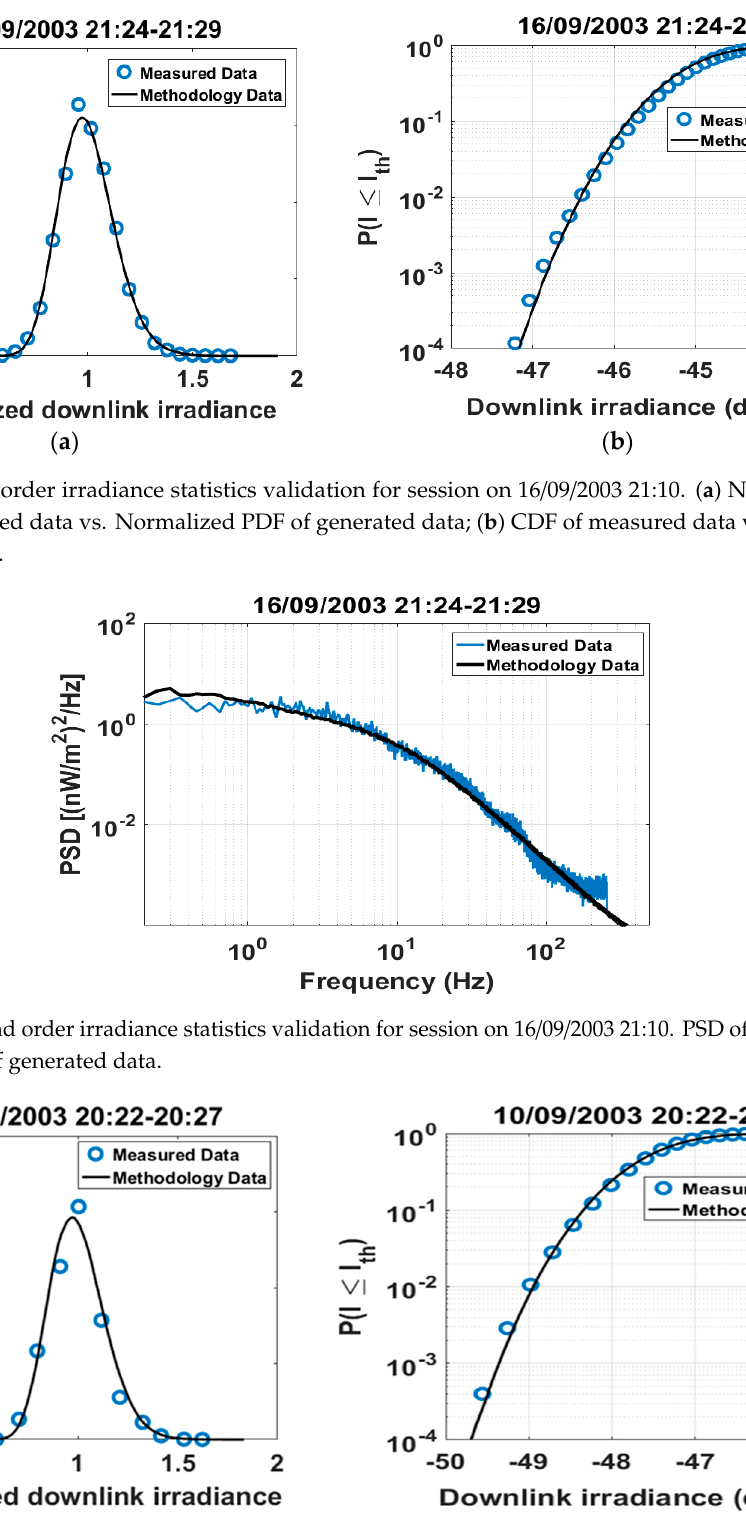
Figure 9. Second order irradiance statistics validation for session on 10/09/2003 20:10. PSD of measured data vs. PSD of generated data. It was observed that the long-term irradiance statistics are re-produced by the proposed synthesizer and fully represent the experimental ones. Concerning the first order statistics results, the scintillation indexes computed from the time- series generated are very similar to the measured ones as well as the corresponding normalized PDFs and CDFs which almost coincide. It is clear that the various wind speeds on the vertical (to the slant path) path cause different turbulence conditions and the larger the wind speed, the greater the SI value. Regarding the second order statistics results, the methodology-obtained PSDs show good agreement with the ones computed from the optical experimental data. Moreover, it can be seen that the scintillation effect is dominant in the frequency range under 10 Hz with a 3dB bandwidth between 6 Hz and 8 Hz. From 10 Hz and after the power spectrum decreases steadily until the 100 Hz where the noise power spectra becomes significant. 4.2. Long-term Received Power In this section the long-term received power statistics, the first order statistics, are presented using the validated synthesizer. The simulation of the turbulent optical channel is performed under